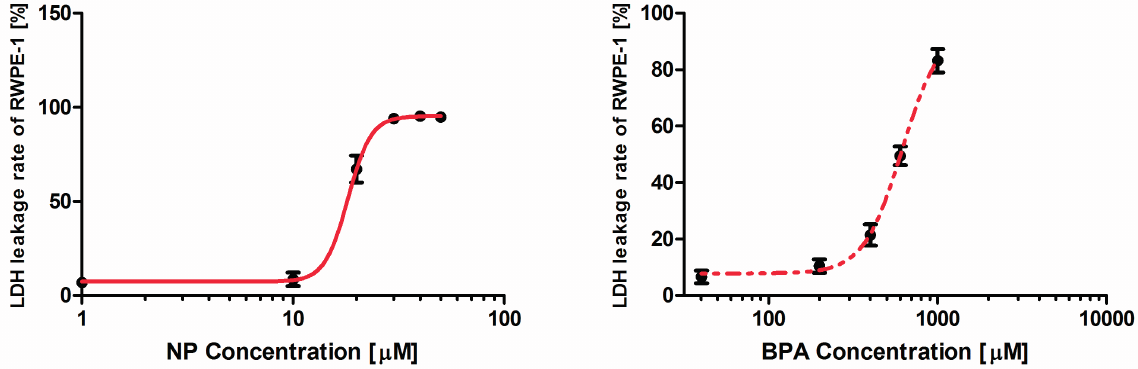
Figure 2. Concentration-response curves for nonylphenol (NP) and bisphenol A (BPA) on the lactate dehydrogenase (LDH) leakage rate of RWPE-1 cell regression from the Hill function. Experimental data are shown for at least three tested donors (each in